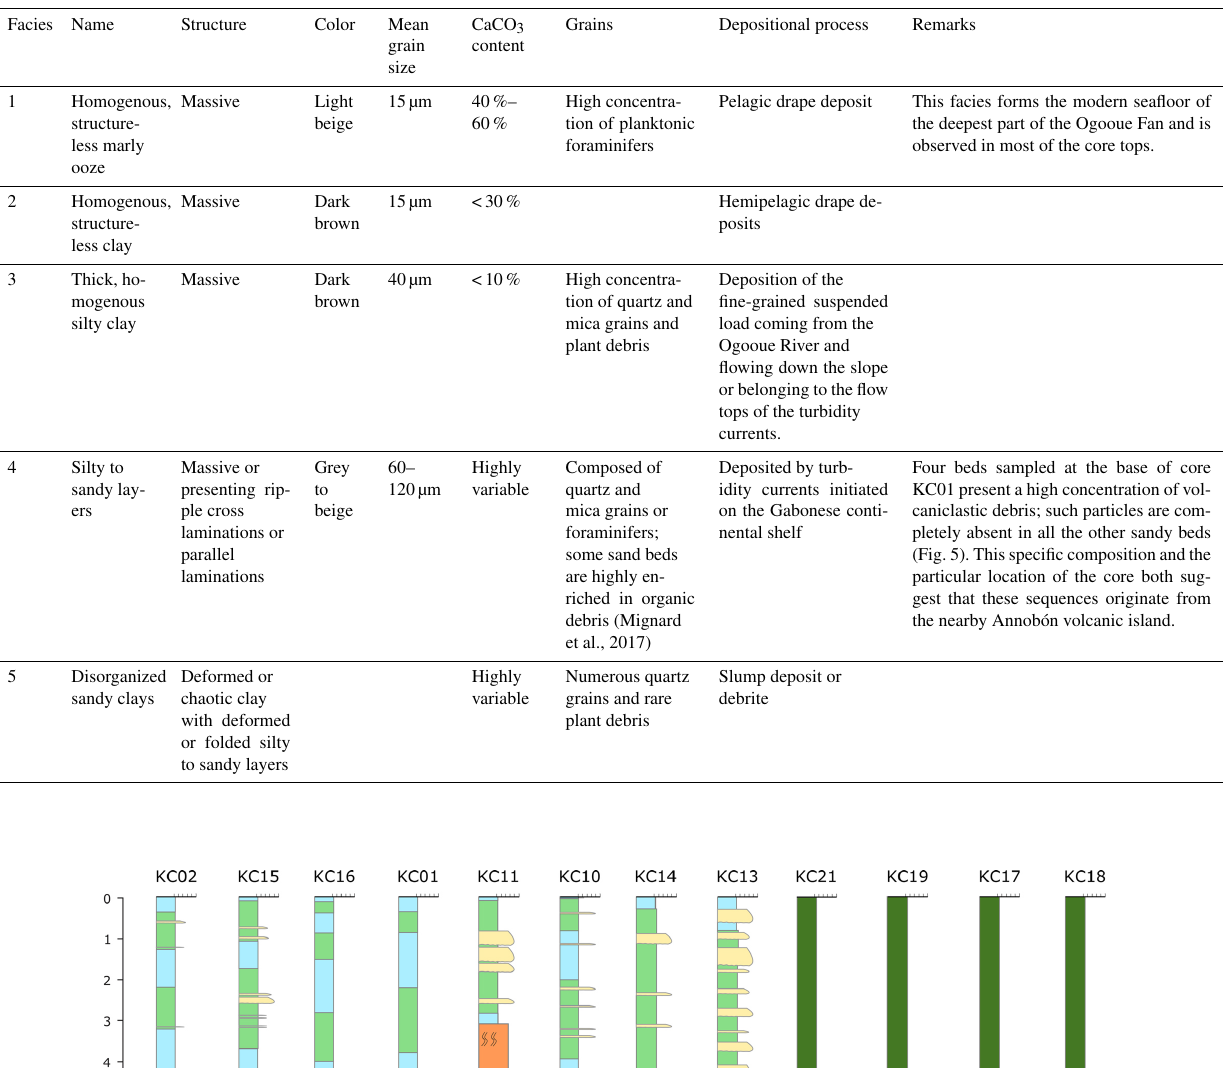
Table 2. Sedimentary facies characteristics.